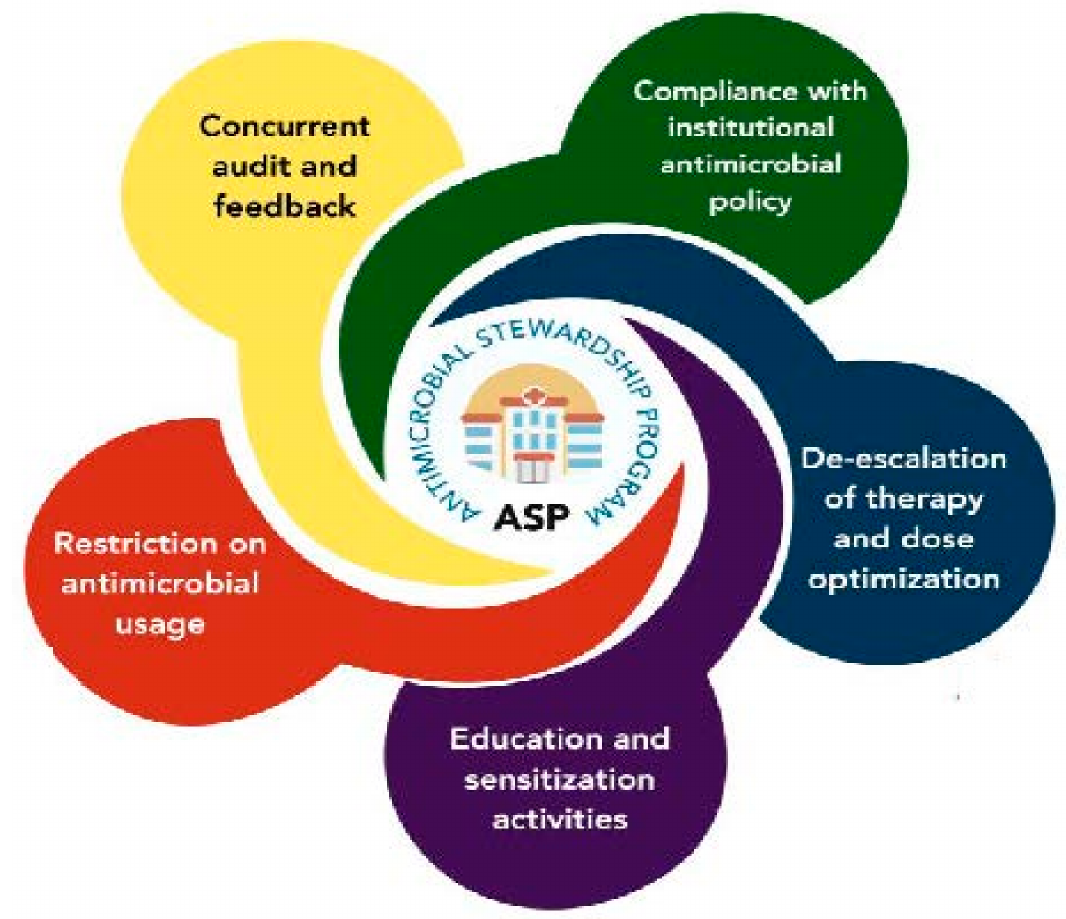
Figure 8. Illustration of an Antimicrobial Stewardship Program (ASP)